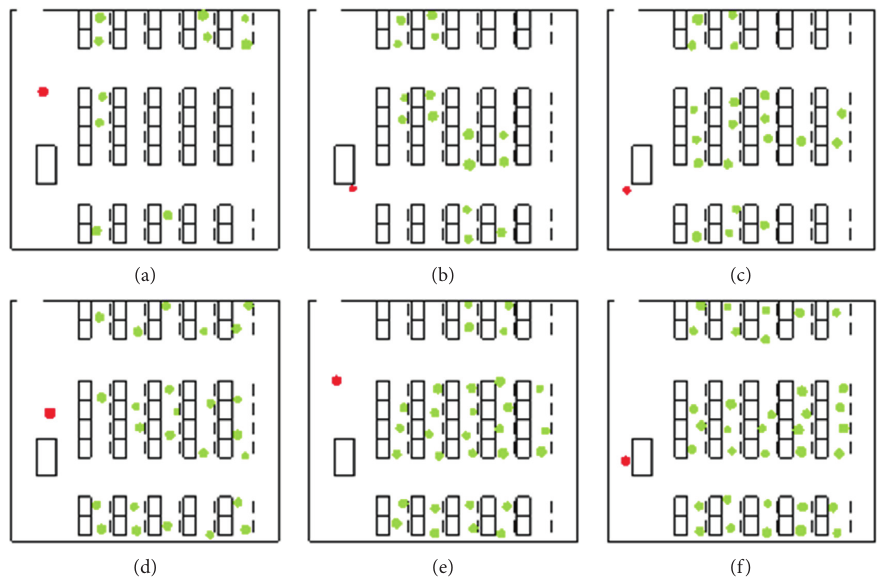
Figure 5: The initial numbers of the crowd for orderly gathering modes. (a) 10p. (b) 15p. (c) 20p (d) 25p. (e) 30p. (f)